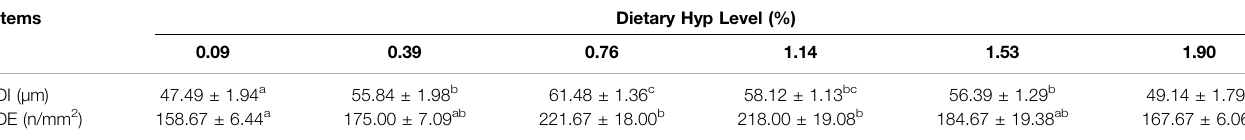
Values are Means ± SE; a, b, c mean values in the same row with different superscript letters are signi fi cantly different ( p < 0.05); Absence of letters indicates no signi fi cant difference between treatments.